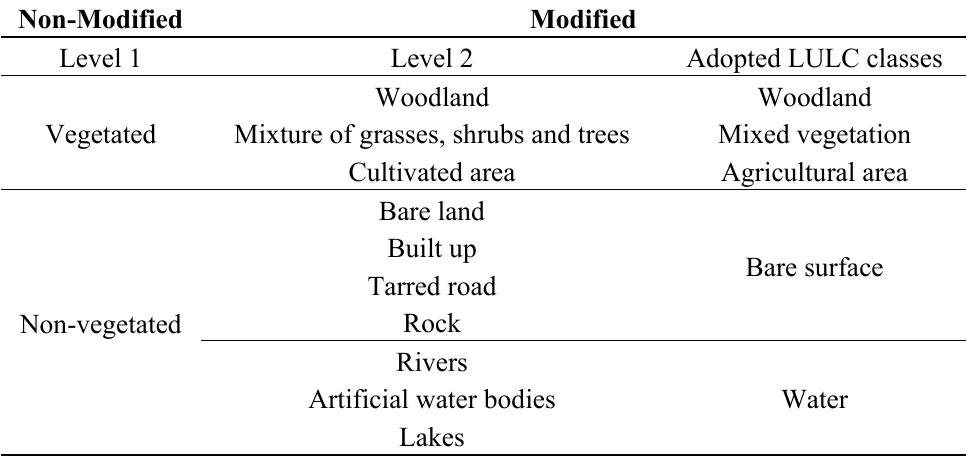
Table 4. Adapted LULC classification scheme, modified from FAO